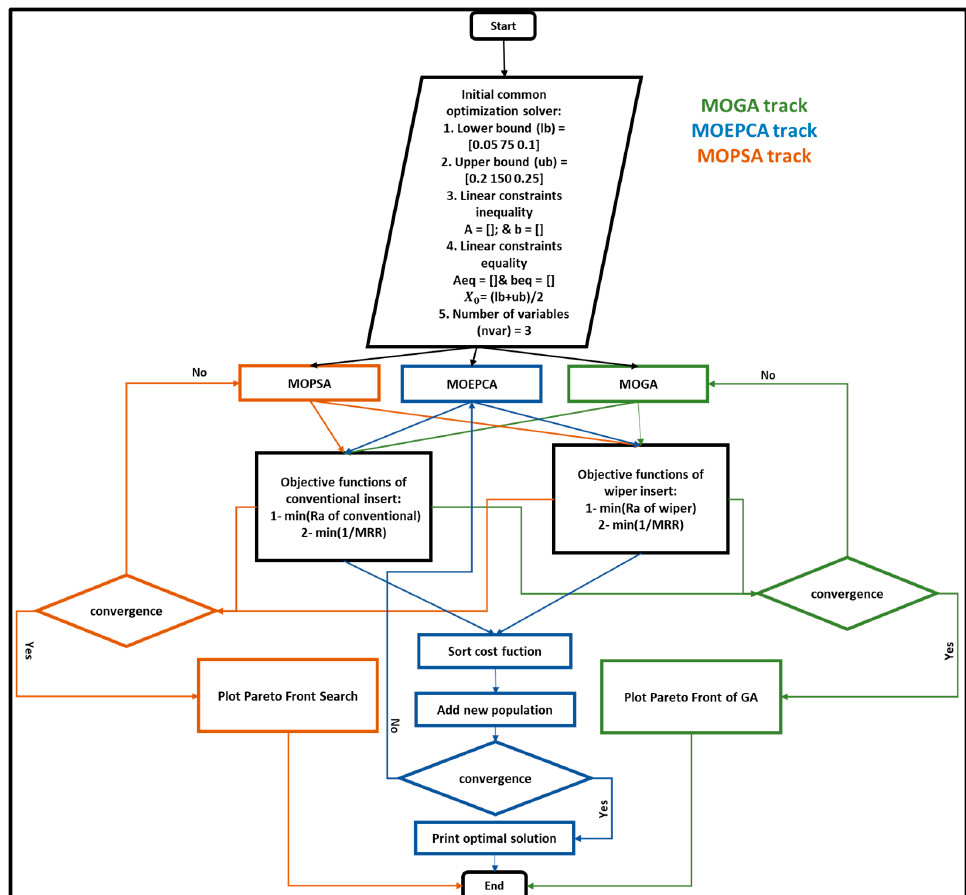
Figure 2. Flowchart of the optimization work.